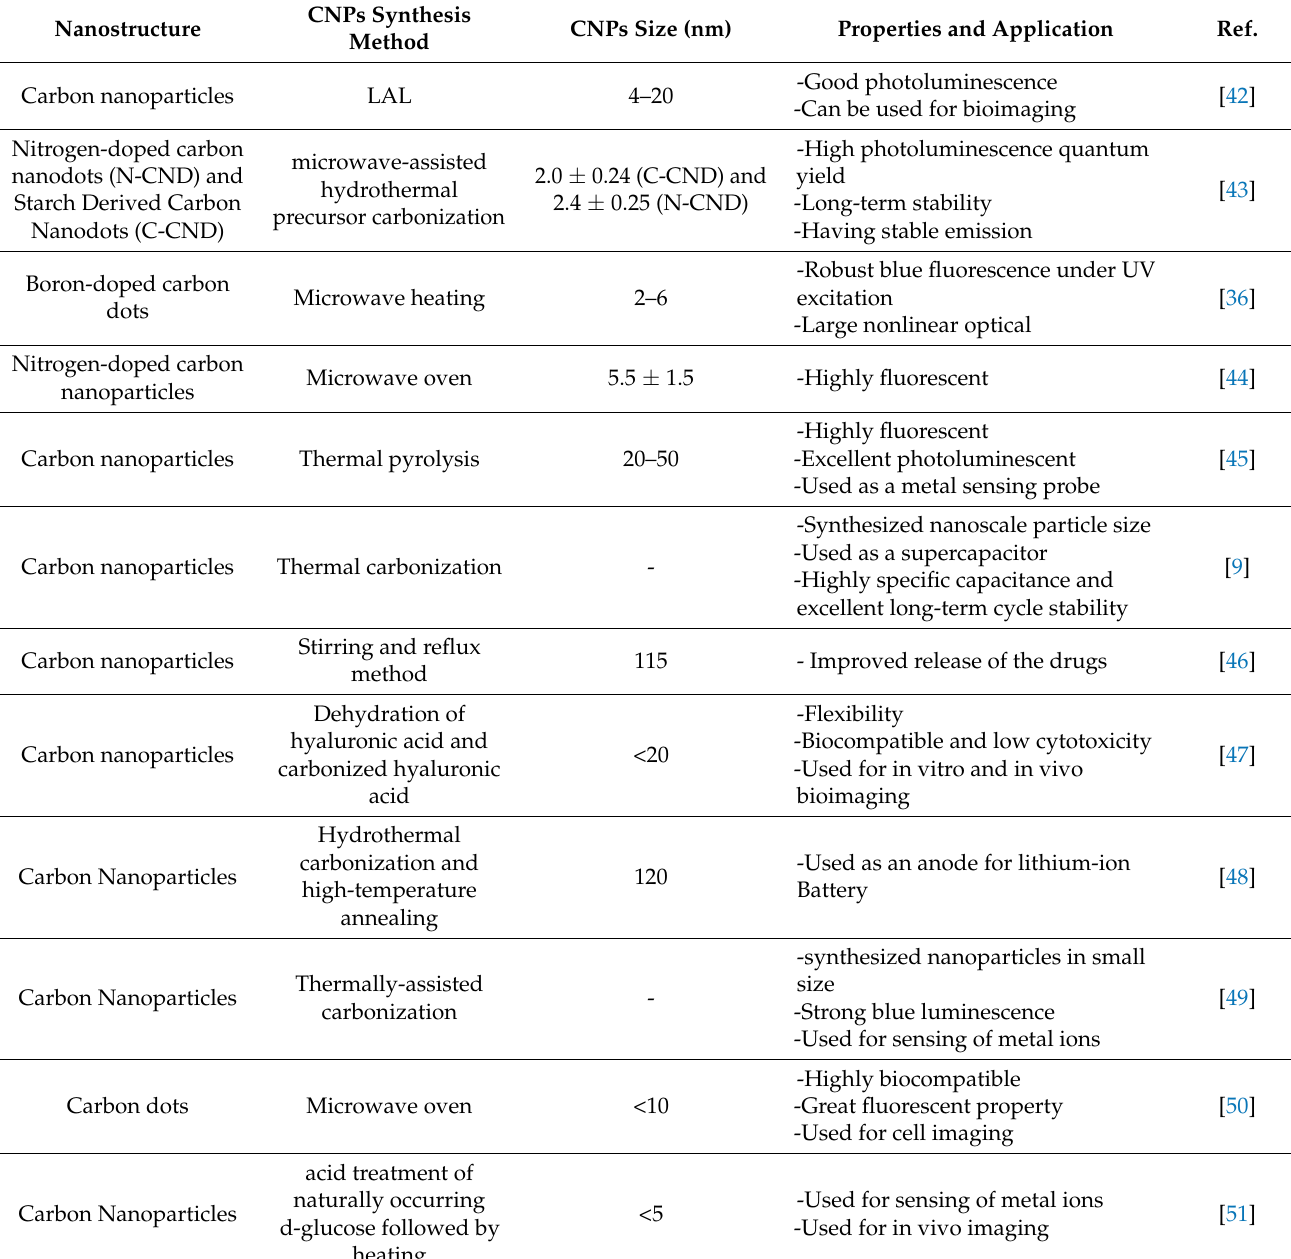
Table 1. Comparison of the synthesized carbon nanoparticles (CNPs) size by different methods.